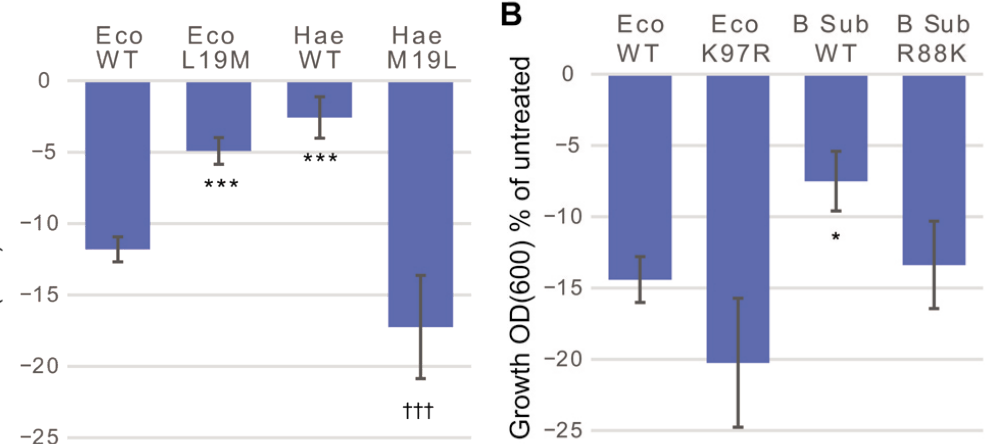
Figure 5. Effect of SCH-79797 on bacteria expressing MscL orthologues and counter mutants. Growth inhibition of MJF455 cultures expressing different constructs after treatment with 1 µ M SCH-79797, expressed as the percentage of the untreated cultures. ( A ) WT Eco MscL, Eco L19M, Hae WT, or Hae M19L. ( B ) WT Eco MscL, Eco K97R, B Sub WT, or B Sub R88K. n ≥ 3 * p ≤ 0.03, *** p ≤ 0.0002, t -test non-paired against WT Eco, ††† p ≤ 0.0005, t -test non-paired against WT